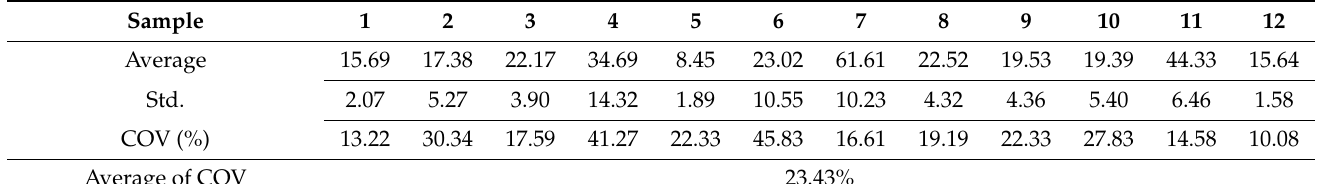
Table 6. Diffusion coefficient of 12 concrete samples (D ac × 10 − 12 m 2 /s).